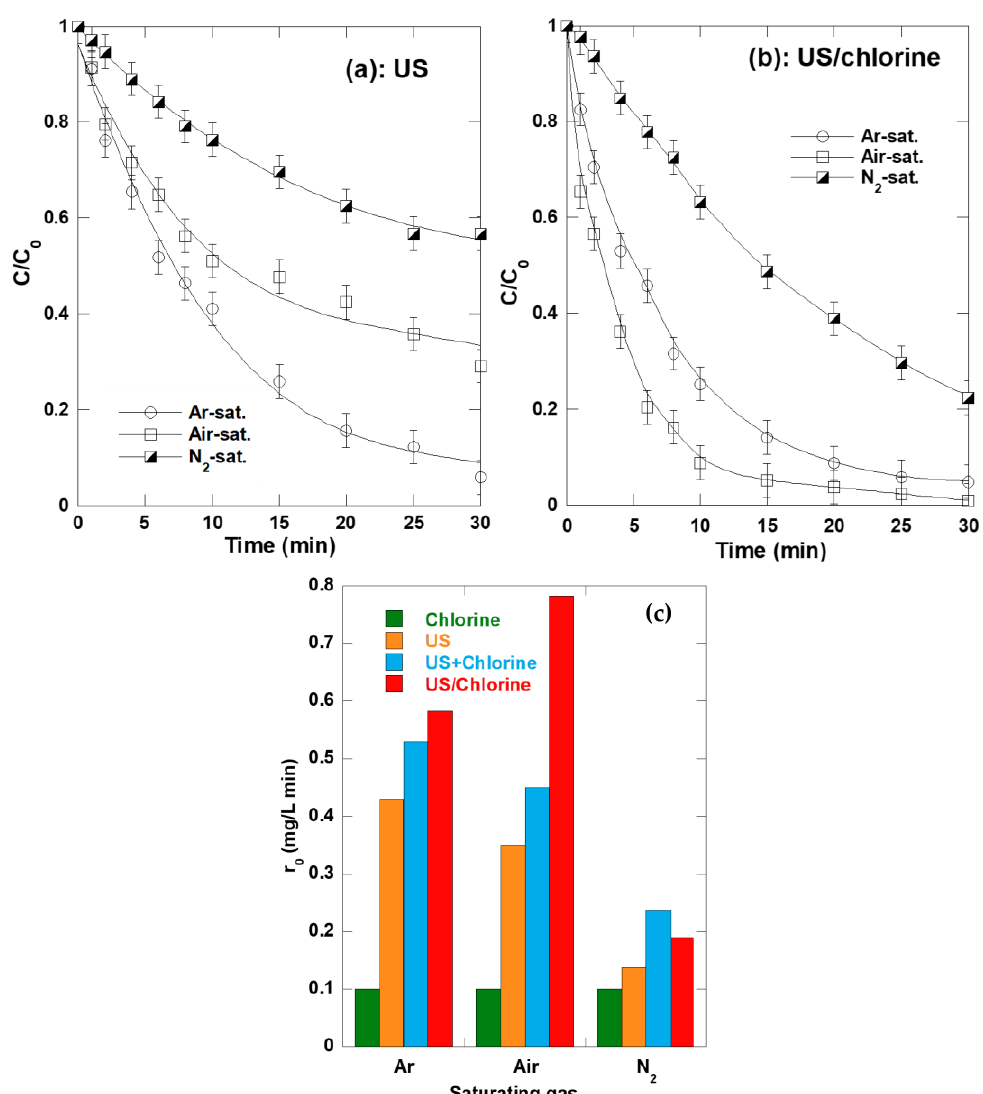
Figure 6. Effect of saturation gases on the performance of US ( a ) and US/chlorine ( b ) processes toward the removal kinetics of ARAC (conditions: C 0 = 5 mg · L − 1 (10 µ M), [chlorine] 0 = 250 µ M, V = 150 mL, pH 5.5, temperature: 25 ± 1 ◦ C, frequency: 600 kHz, power: 120 W) and variation in ARAC initial removal rate (r 0 ) with respect to saturating gas for chlorination alone, US alone and US/chlorine combination ( c ) (the sum of the two processes separately, US + chlorine, was added for comparison with the combined process).